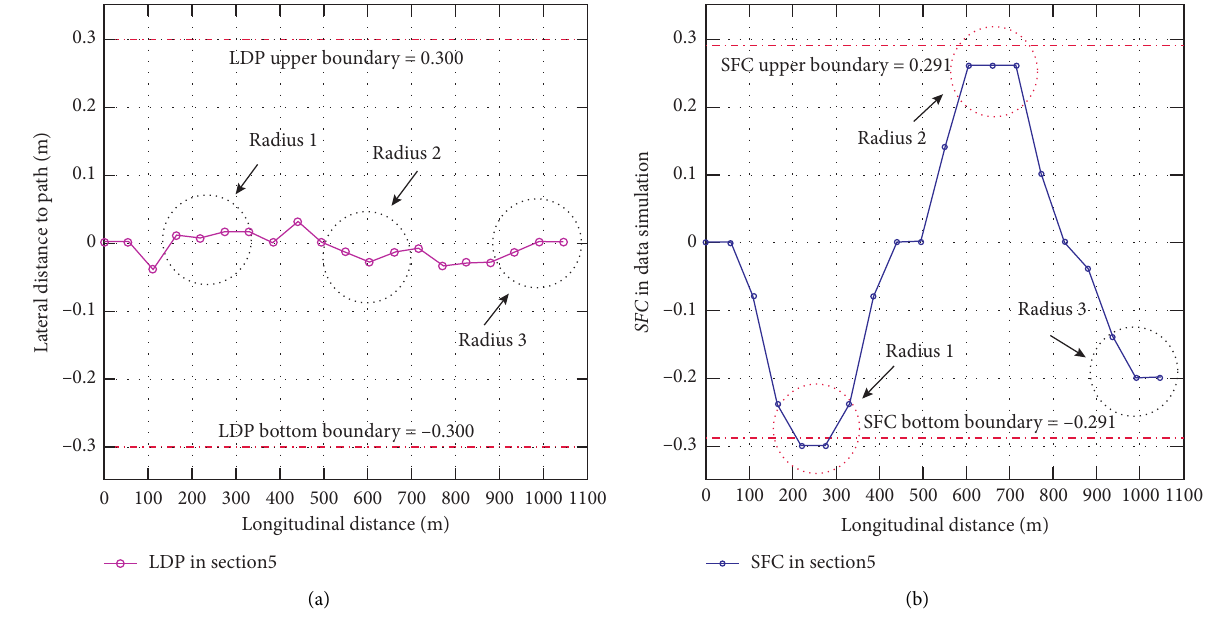
Figure 12: The simulation results of Section 5. (a) Lateral Distance Path Change Trend. (b) SFC Change